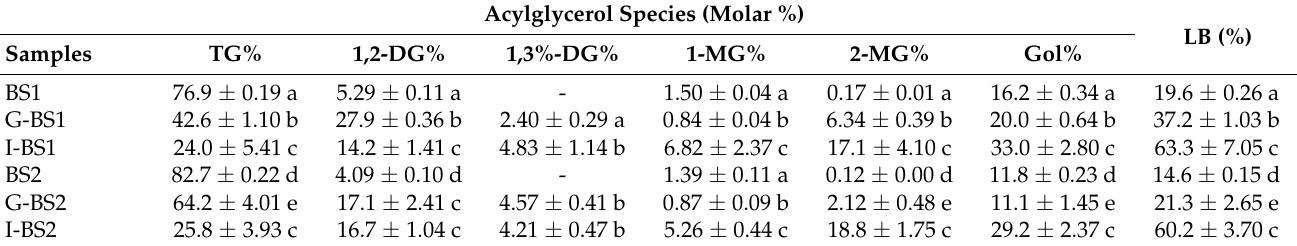
Table 1. Molar percentages of triacyglycerols (TG%), diacylglycerols (1,2-DG% and 1,3-DG%), monoa- cylglycerols (1-MG% and 2-MG%) and glycerol (Gol%) in relation to the total number of glyceryl structures and lipid bioaccessibility (LB %) in black seed oil samples (BS1 and BS2), encapsulated black seed oil samples after gastric (G-BS1, G-BS2) and intestinal (I-BS1, I-BS2) in vitro digestion. Acylglycerol Species (Molar %)